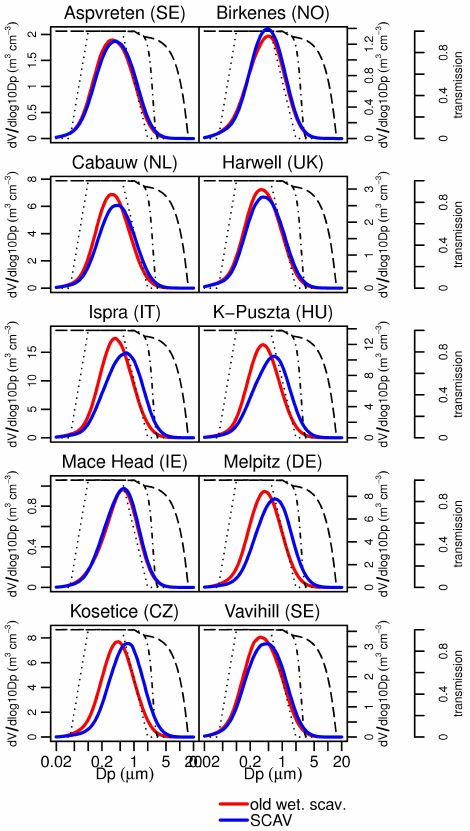
Fig. 7. Modeled aerosol volume concentration size distributions at selected stations for the autumn 2008 period. Reference simulation (red) and a simulation including SCAV and cloud processing (blue) are shown as thick solid lines. For reference the transmission func- tions of an AMS (dotted line), a PM 2 . 5 (dash-dotted line) and a PM 10 (dashed line) inlet system as calculated in Knote et al. (2011) are given as well. Shown are only the volume contributions of the modes containing secondary components (fresh and mixed Aitken and accumulation